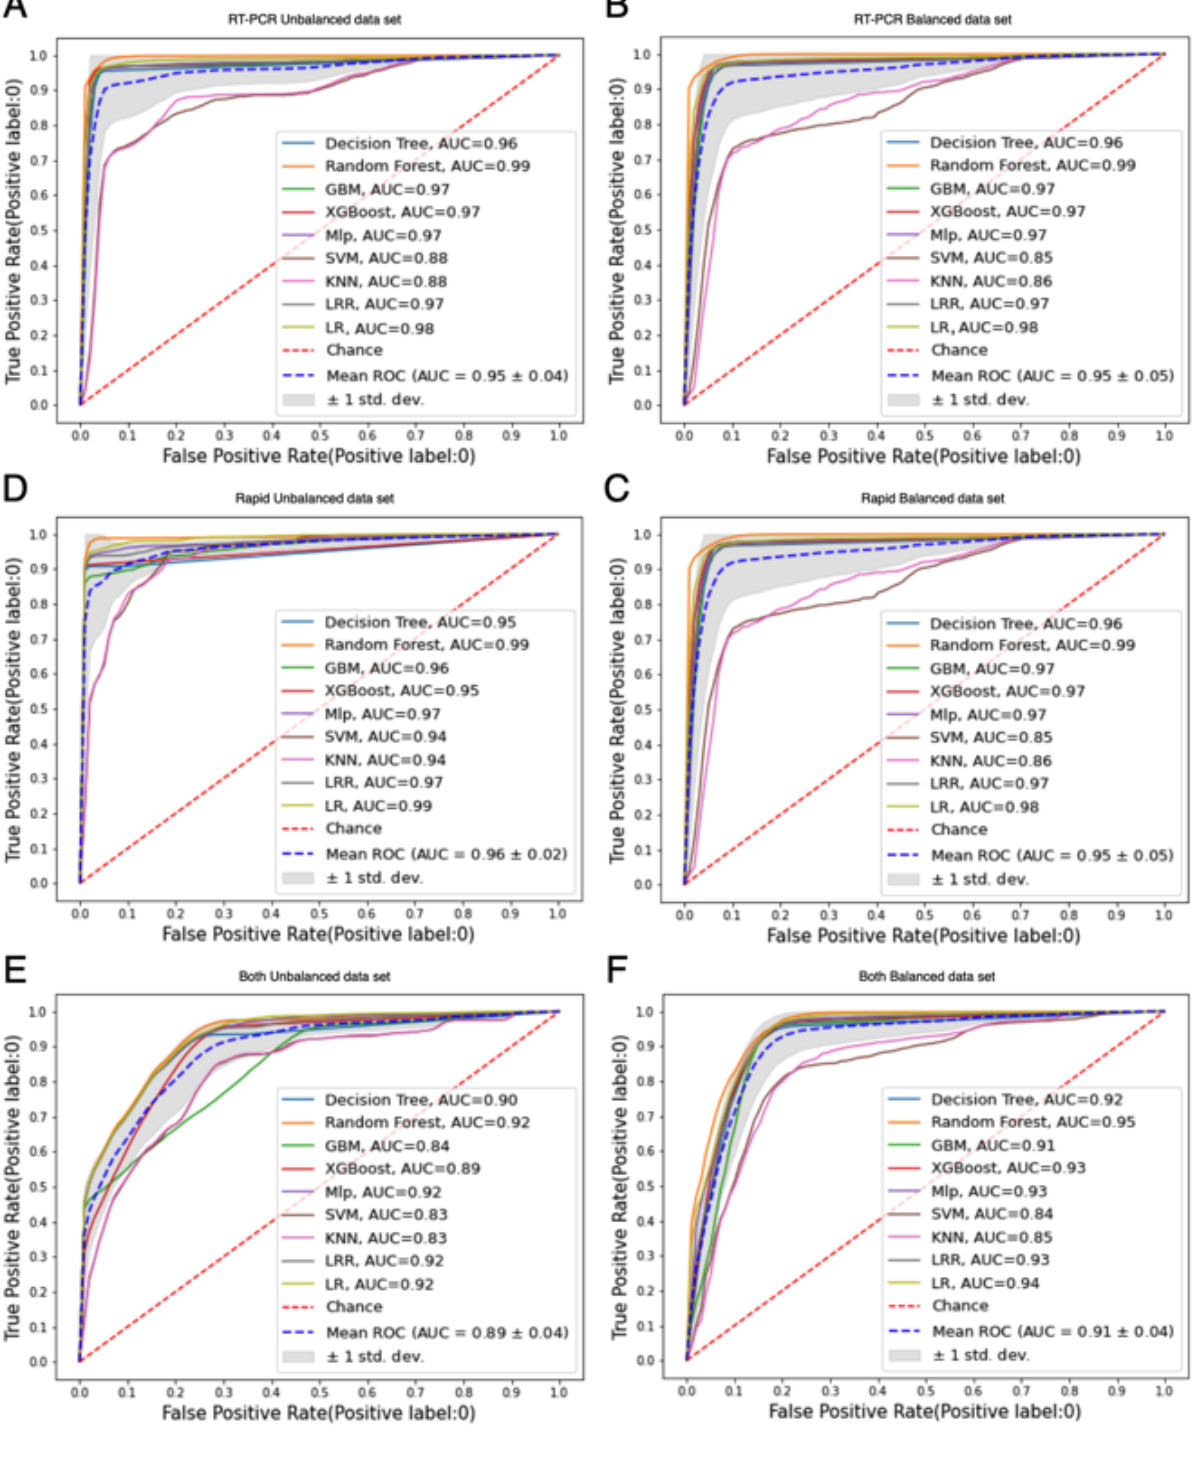
Figure 4. The models' ROC curves with (A) RT-PCR unbalanced, (B) RT-PCR balanced, (C) rapid unbalanced, (D) rapid balanced, (E) both unbalanced, and (F) both balanced. AUC: area under the receiver operating characteristic curve; GBM: gradient boosting machine; KNN: k-nearest neighbors; LR: logistic regression (weak regularization); LRR: logistic regression (strong regularization); Mlp: multilayer perceptron; ROC: receiver operating characteristic; RT-PCR: reverse transcription polymerase chain reaction; SVM: support vector machine; XGBoost: extreme gradient